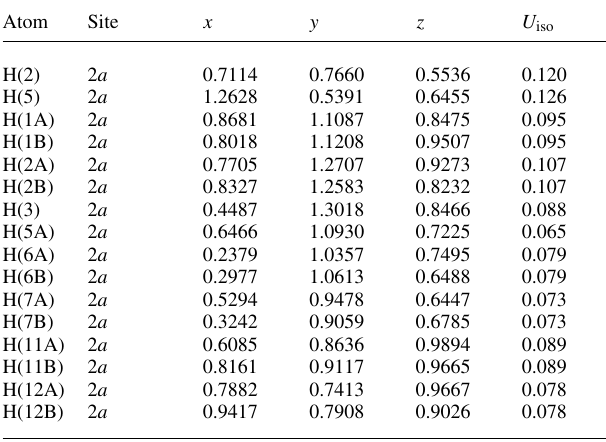
Table 2. Atomic coordinates and displacement parameters (in Å 2 )